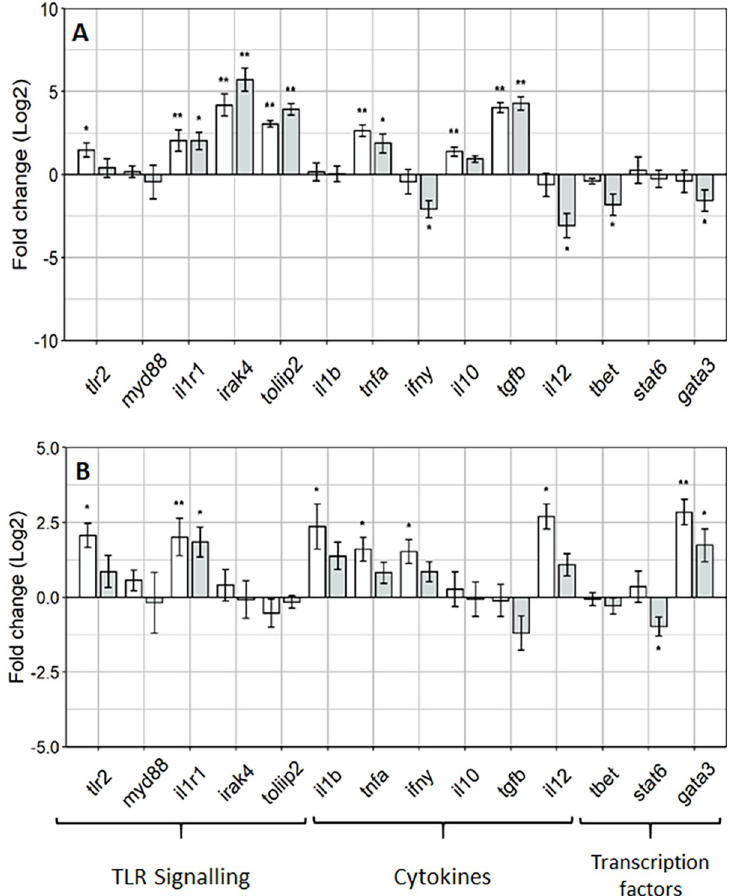
Fig 2. Rainbow trout posterior intestine show regulation of innate and adaptive responses through induction of TLR signalling. Gene expression profiles posterior intestine of rainbow trout at week 4 (A) and 8 (B) relative to the Control (dotted line). Data presented mean ± SEM (n = 6 fish per treatment; Fold change(log2)); light grey bars indicate fish fed MsYF continuously, dark grey bars indicate fish fed MsYF pulsed with control every 2 weeks. Asterisks denote significant differences between treatment and control groups: � = P < 0.05; �� = P < 0.01.